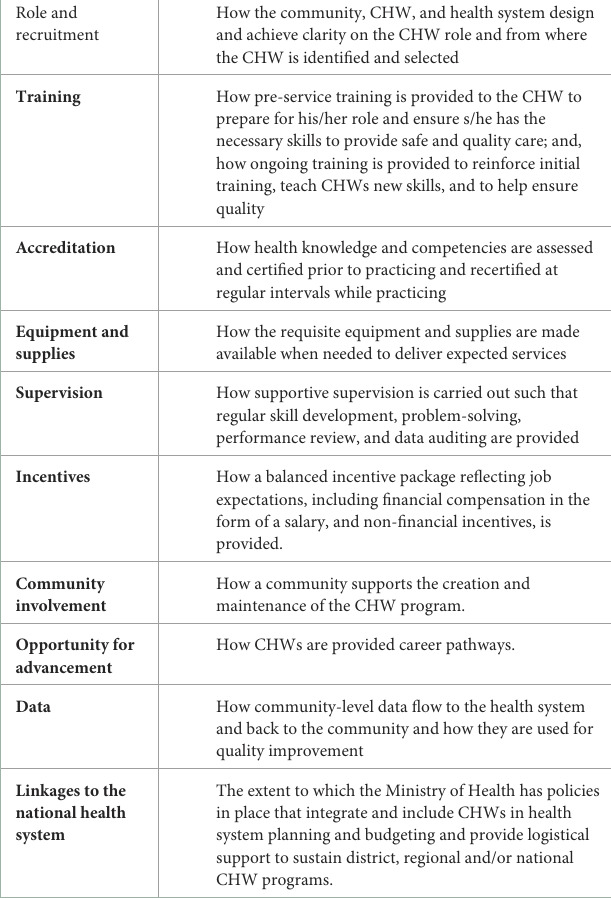
TABLE 1 CHWAIM assessment framework